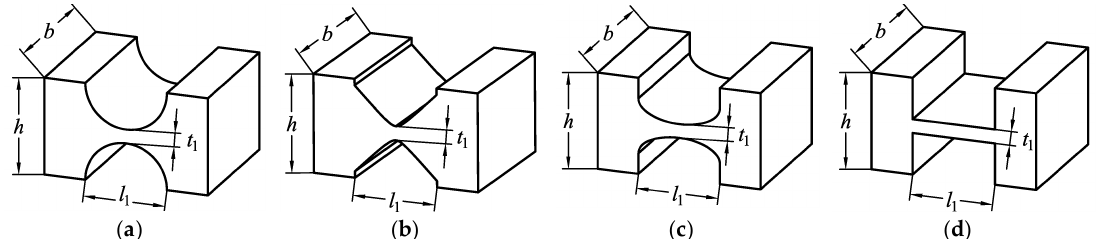
Figure 2. Four commonly used flexure hinges: ( a ) Circular notch, ( b ) hyperbolic notch, ( c ) elliptical notch, and ( d ) right angle notch.